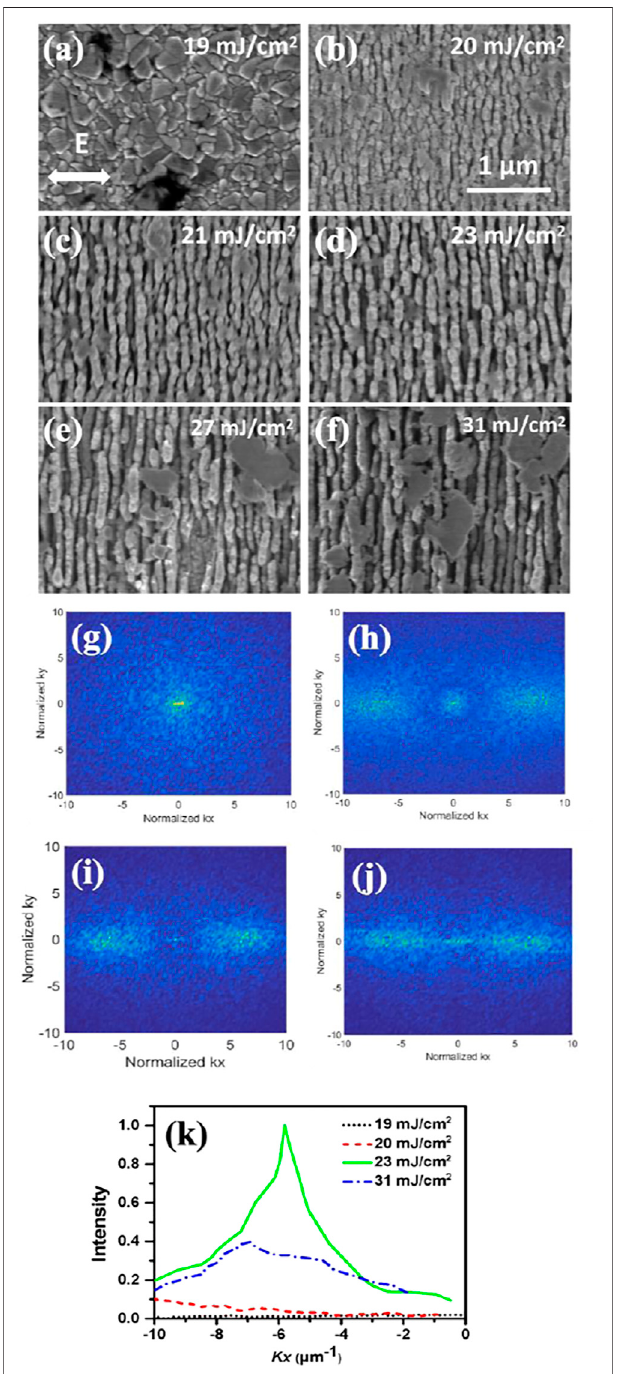
FIGURE3|(A – F) SEMimagesofthenanostructuredFTO fi lm. (G – J) are 2D-FT images of LIPSS in (A,B,D, and F) , respectively. (K) FT spectra at k y = 0 μ m − 1 in (G – J) . Scanning speed is 0.01 mm/s.